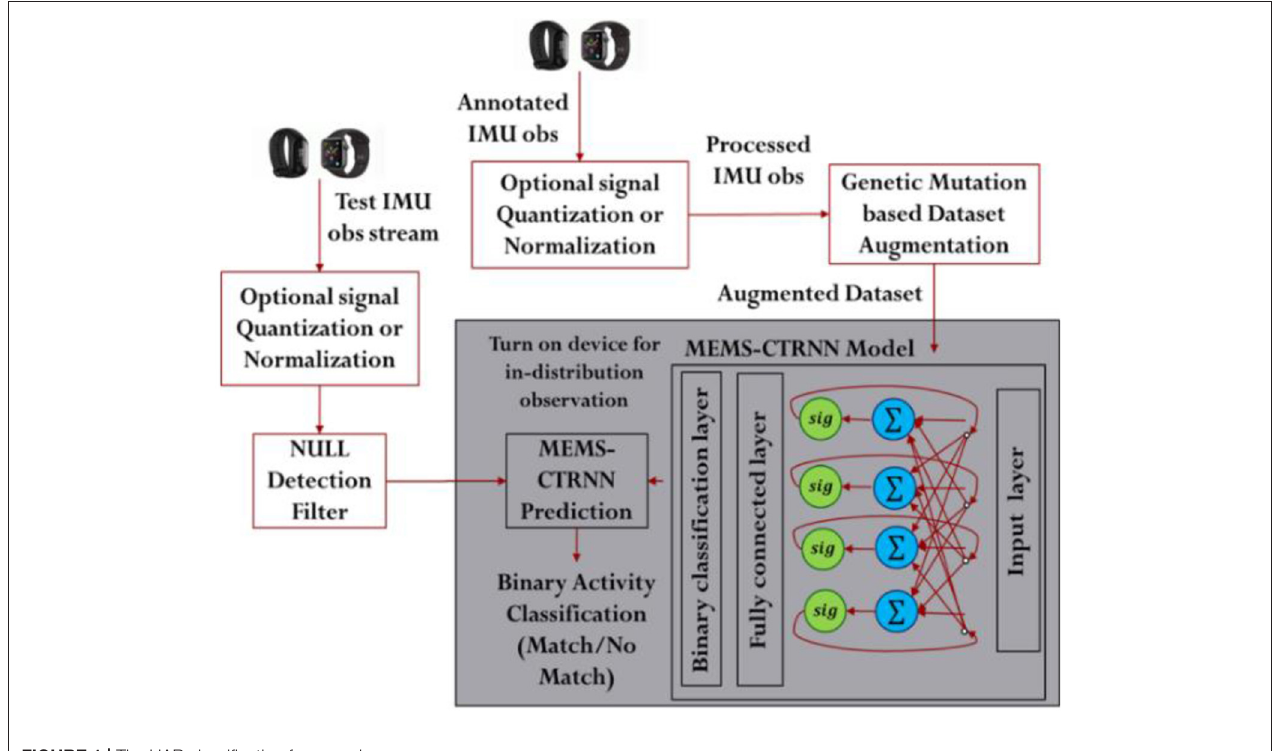
FIGURE 1 | The HAR classification